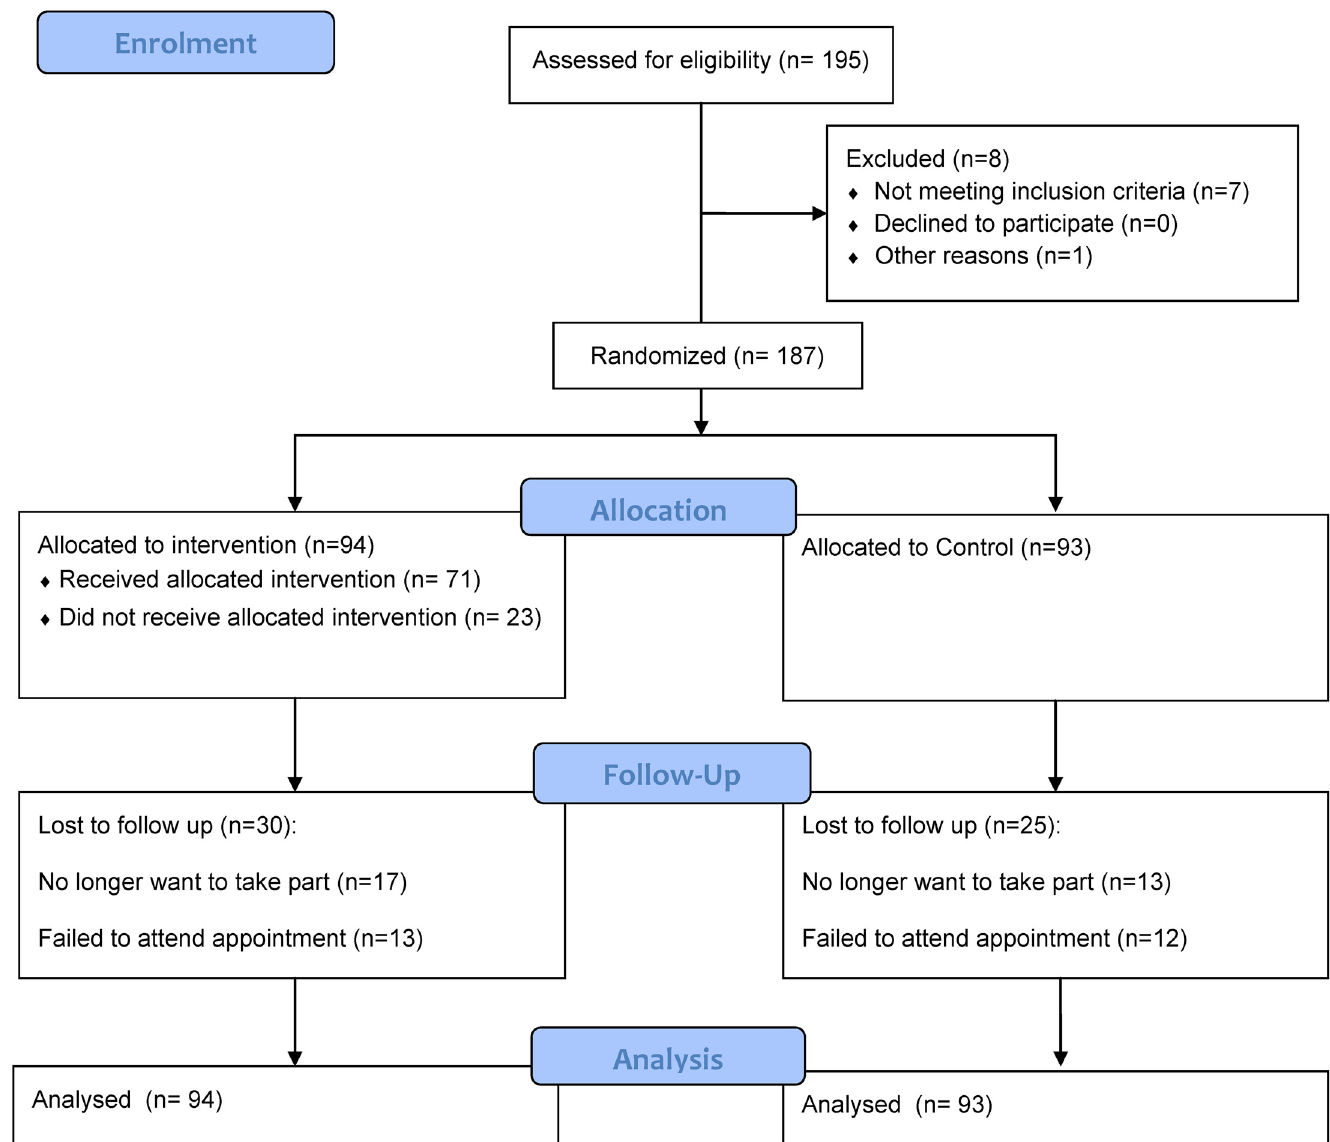
Fig 1. CONSORT diagram of participant flow through the